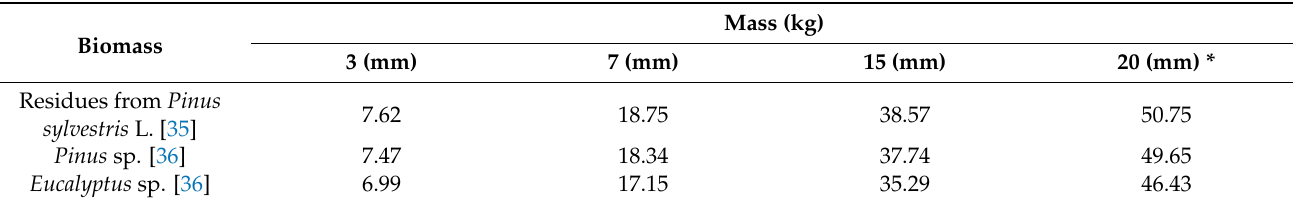
Table 16. Maximum reduction in the kiln’s charge by using several